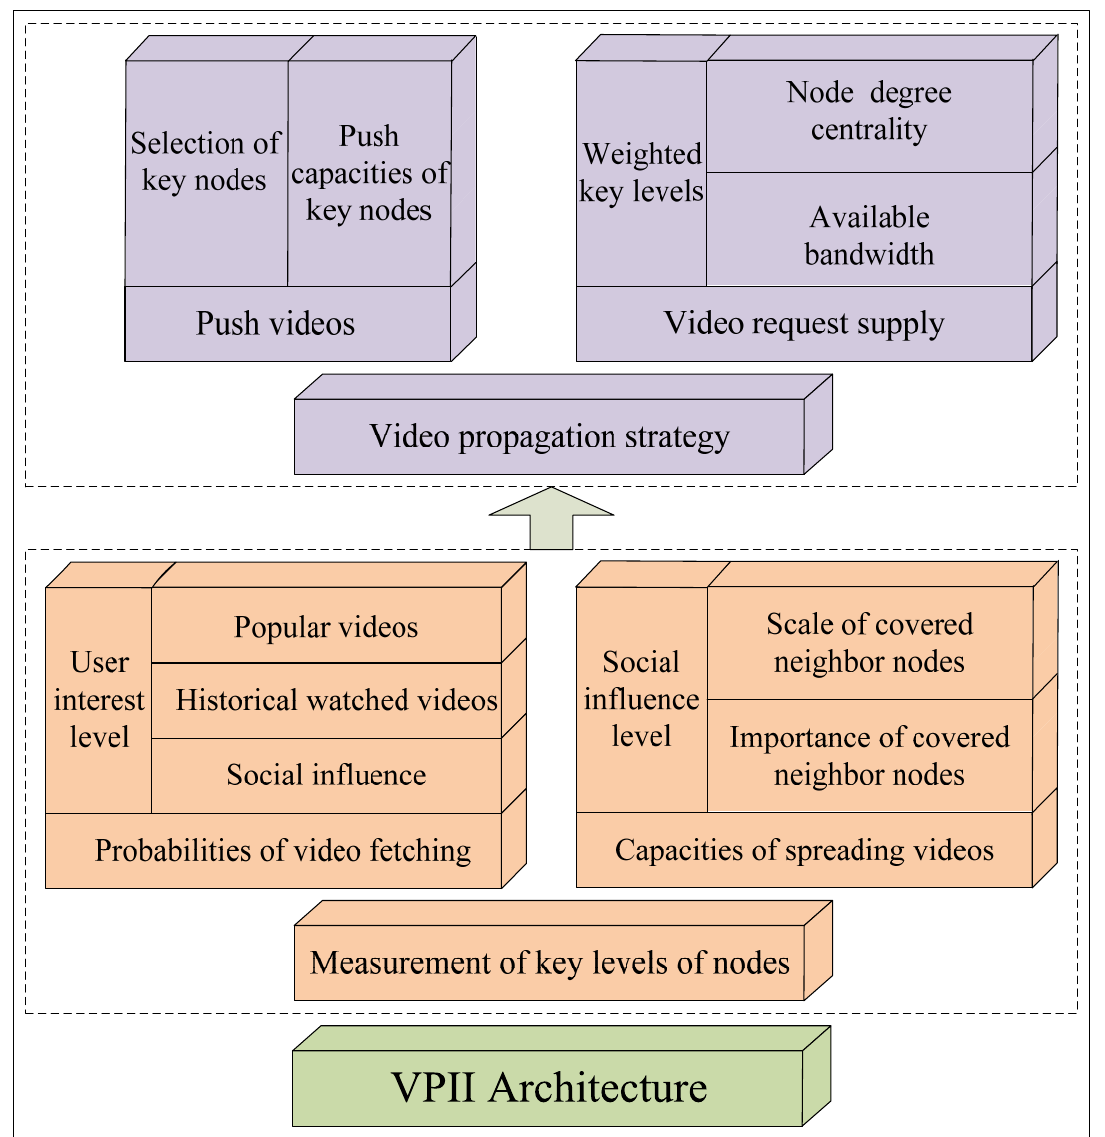
Figure 2. Relationship between components and elements of